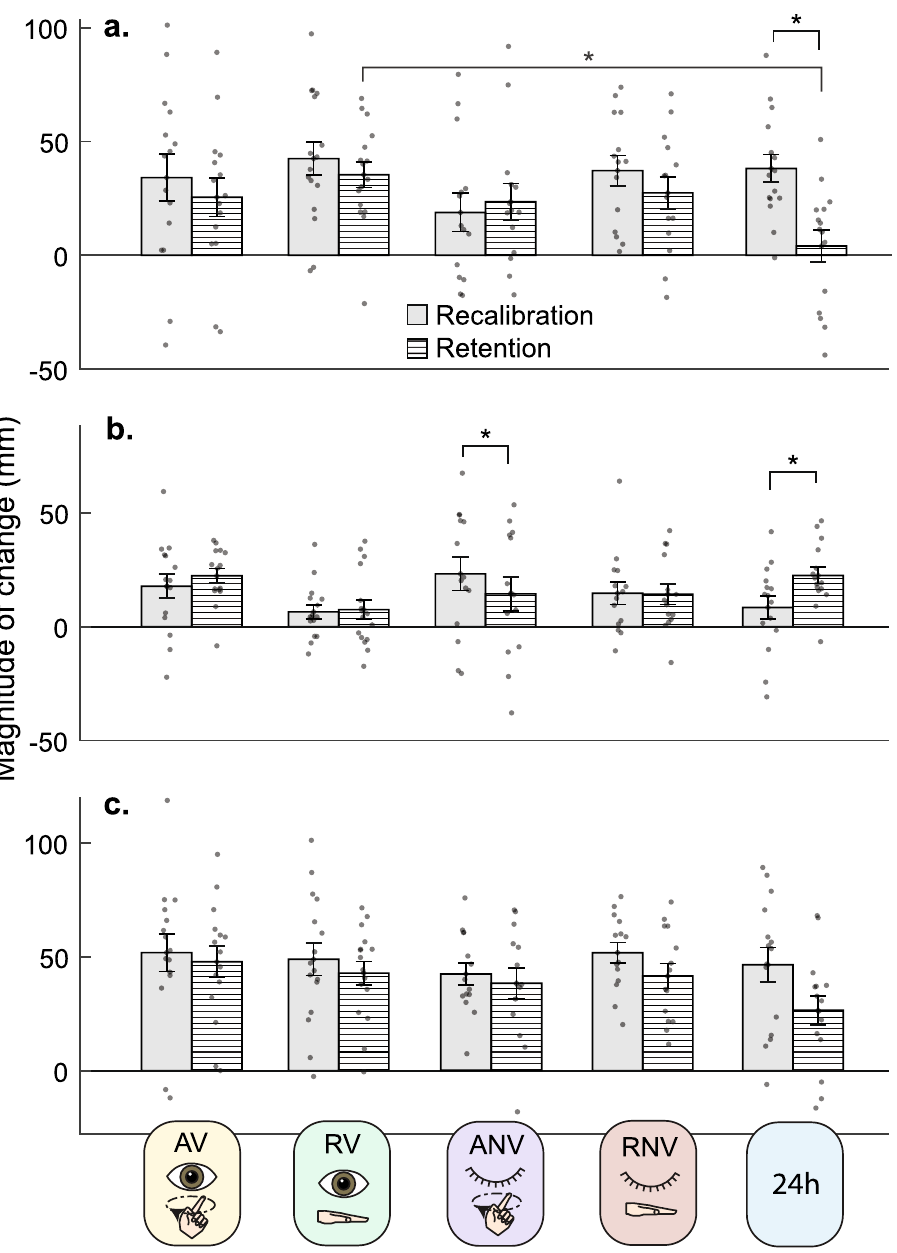
Figure 4. Mean group recalibration and retention with standard errors and individual data points. ( A ) Vision. There was a significant group x task stage interaction. Recalibration occurred similarly across groups. Retention significantly differed between Rest/Vision (RV) and 24H group. Within groups, Recalibration and Retention differed in the 24 h group (35.6 mm) where retention was significantly less than recalibration. ( B ) Proprioception. There was a significant group x task stage interaction. Recalibration and Retention occurred similarly across groups. Within groups there was a significant difference in the recalibration and retention block for Active/No Vision and 24H group. ( C ) Total. There was no significant interaction between the group and task stage. * p < 0.05 for group x task stage ANOVA